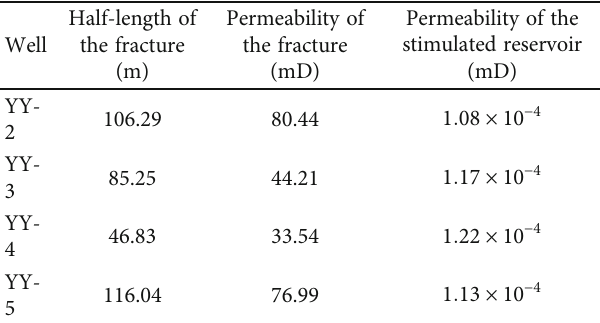
Table 5: Parameter inversion results for wells YY-2 ~ YY-5 (ignoring the uneven support of